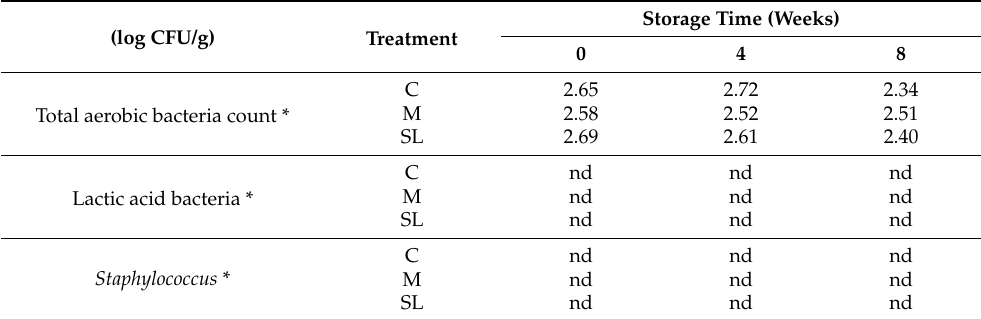
Table 4. Microbiological quality of experimental treatments during storage